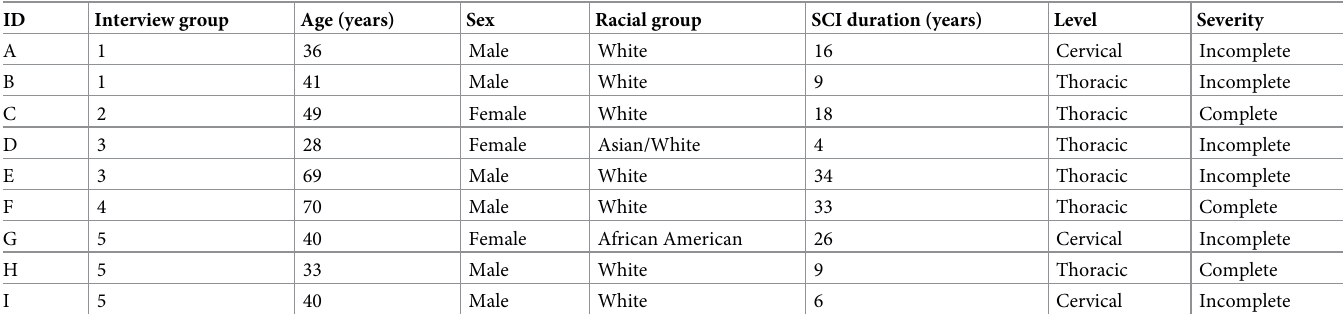
Table 1. Demographic features of study participants.